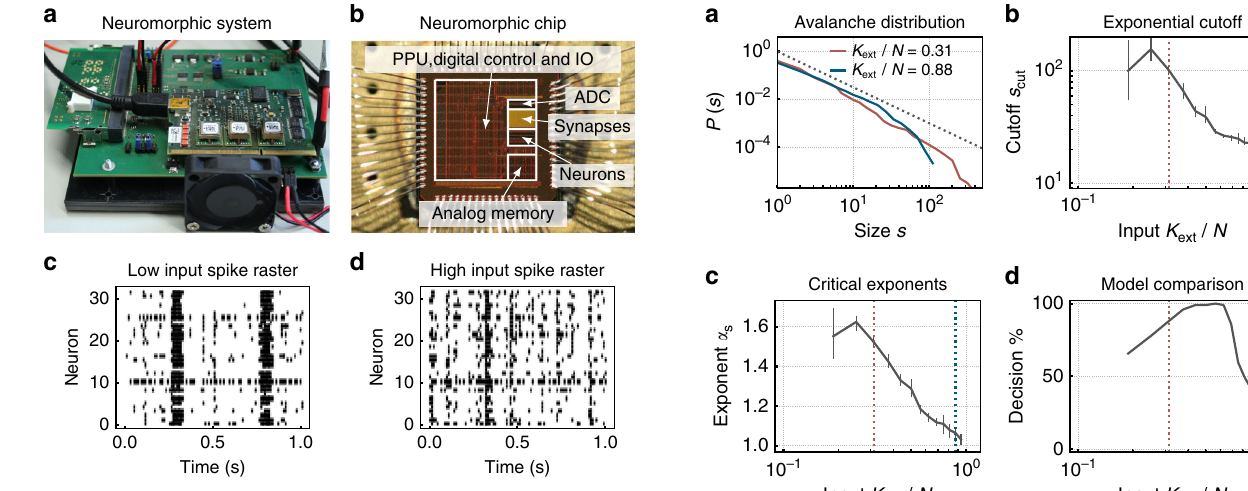
Fig. 1 The degree of external input K ext shapes the collective dynamics of the network. a The neural network is implemented on the prototype neuromorphic hardware system BrainScaleS 2. b This system features an analog-neural network core as well as an on-chip general purpose processor that allows for fl exible plasticity implementation. c For low degree of input ( K ext = 0.25), strong recurrent connections develop, and the activity shows irregular bursts, resembling a critical state. d For high degrees of input ( K ext = 0.56), fi ring becomes more irregular and irregular for high K ext .